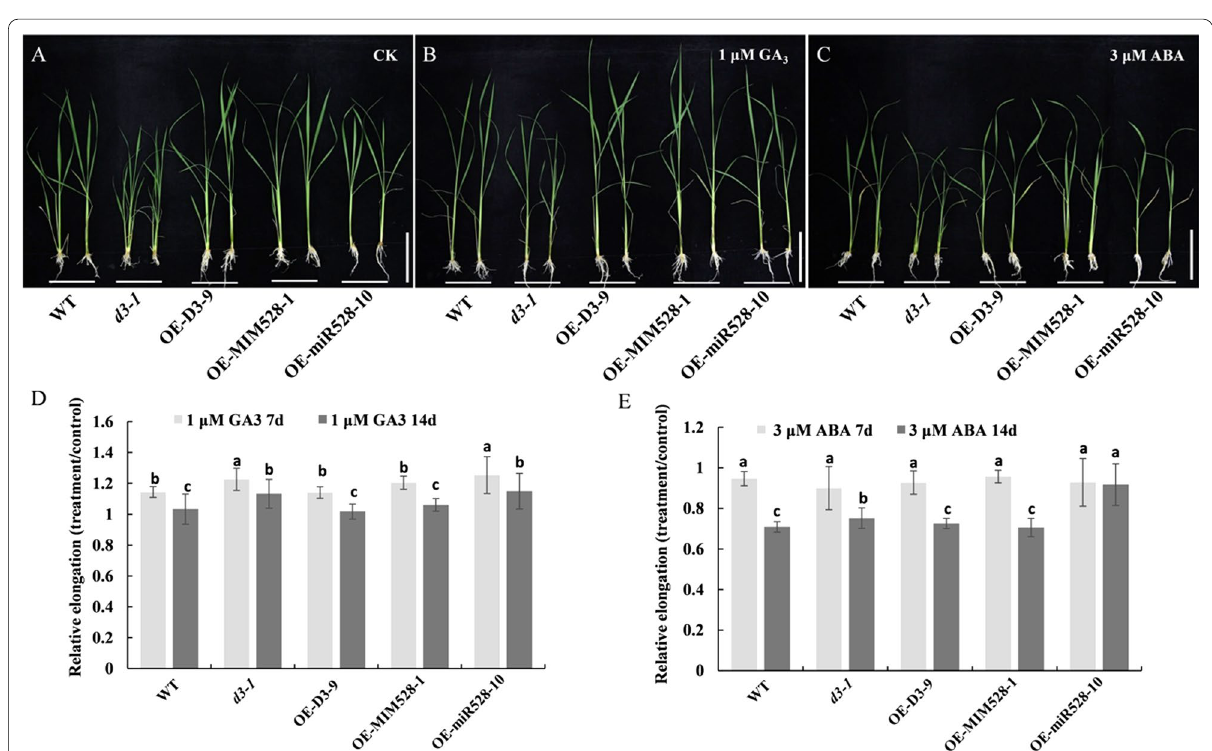
Fig. 5 Response of WT and transgenic lines to exogenous GA and ABA treatment. A Phenotype of WT and transgenic plants under normal conditions; B , C Phenotypes of 14-day-old seedlings of WT and transgenic lines under the treatment with exogenous 1 μM GA 3 ( B ) and 3 μM ABA ( C ) for 7 days. D Relative elongation of plant height after 1 μM GA 3 treatment for 7 and 14 days. E Relative elongation of plant height after 3 μM ABA treatment for 7 and 14 days. Data are shown as the means S.D. (n 10). Significant differences ( P < 0.05) are indicated by different ± =